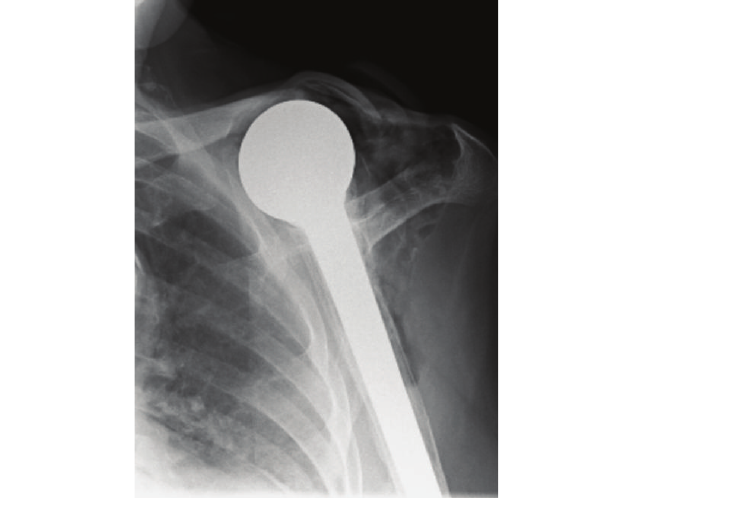
Figure 1: AP left shoulder on initial presentation February 12, 2009. Note the distal clavicle destruction, gas in the soft tissues, and the abnormal position of the prosthesis.